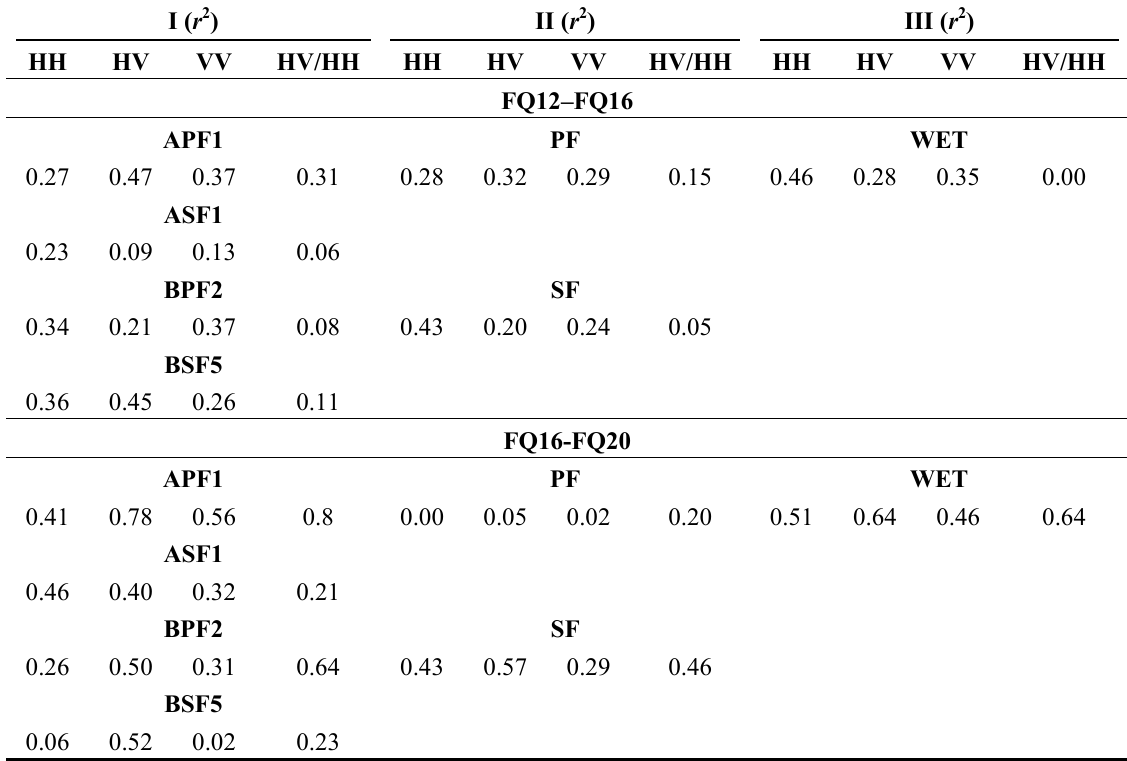
Table 4. Regression adjustments for HH, HV, VV and HH/HV, respectively ( r 2 for soil moisture). Points used in the regression analysis: 13 for peatland A and 12 for peatland